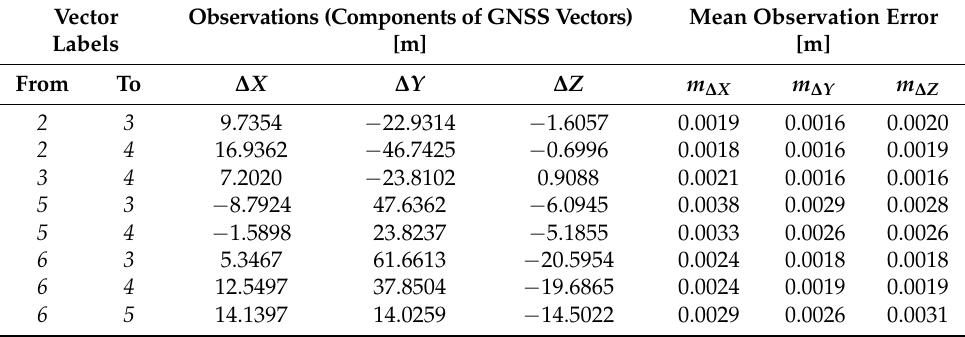
Table 1. Measured GNSS vectors and their mean